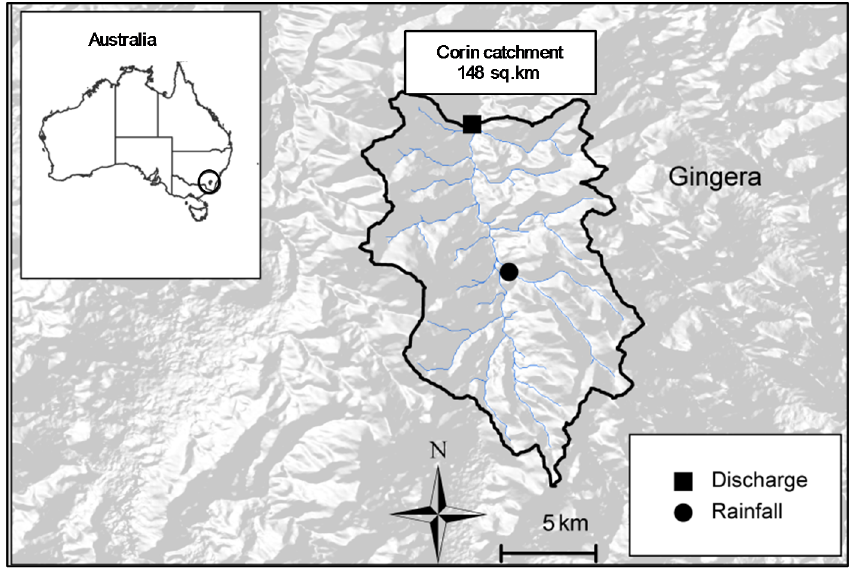
Figure 1. Study area and location of hydrometry station and the precipitation